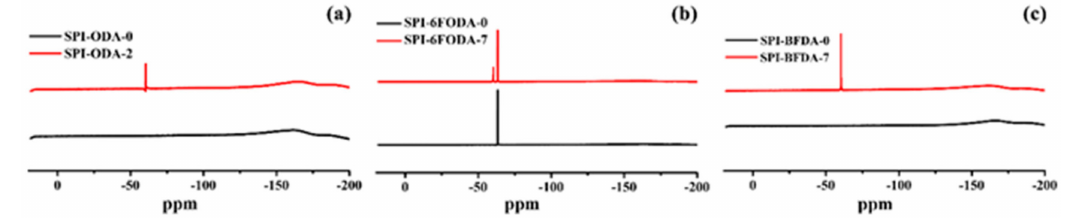
Figure 3. 19 F NMR spectra of the ( a ) SPI-ODA, ( b ) SPI-6FODA, and ( c ) SPI-BFDA.